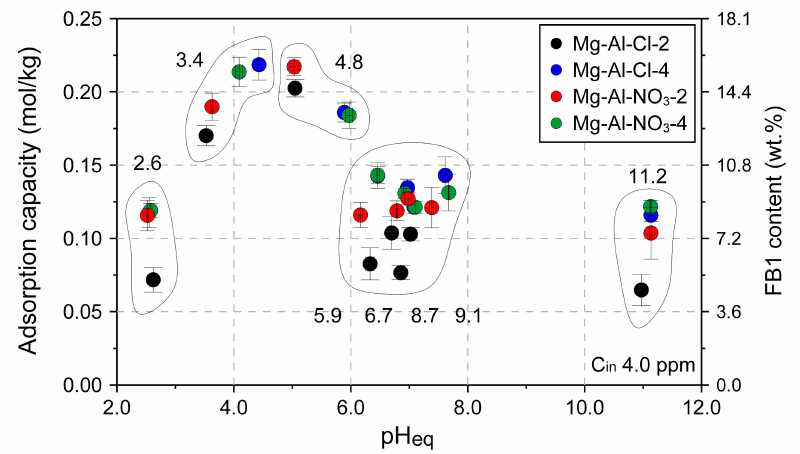
Figure 7. The pH e ff ect on adsorption capacity of selected LDH materials. The values on the graph indicate initial pH values.